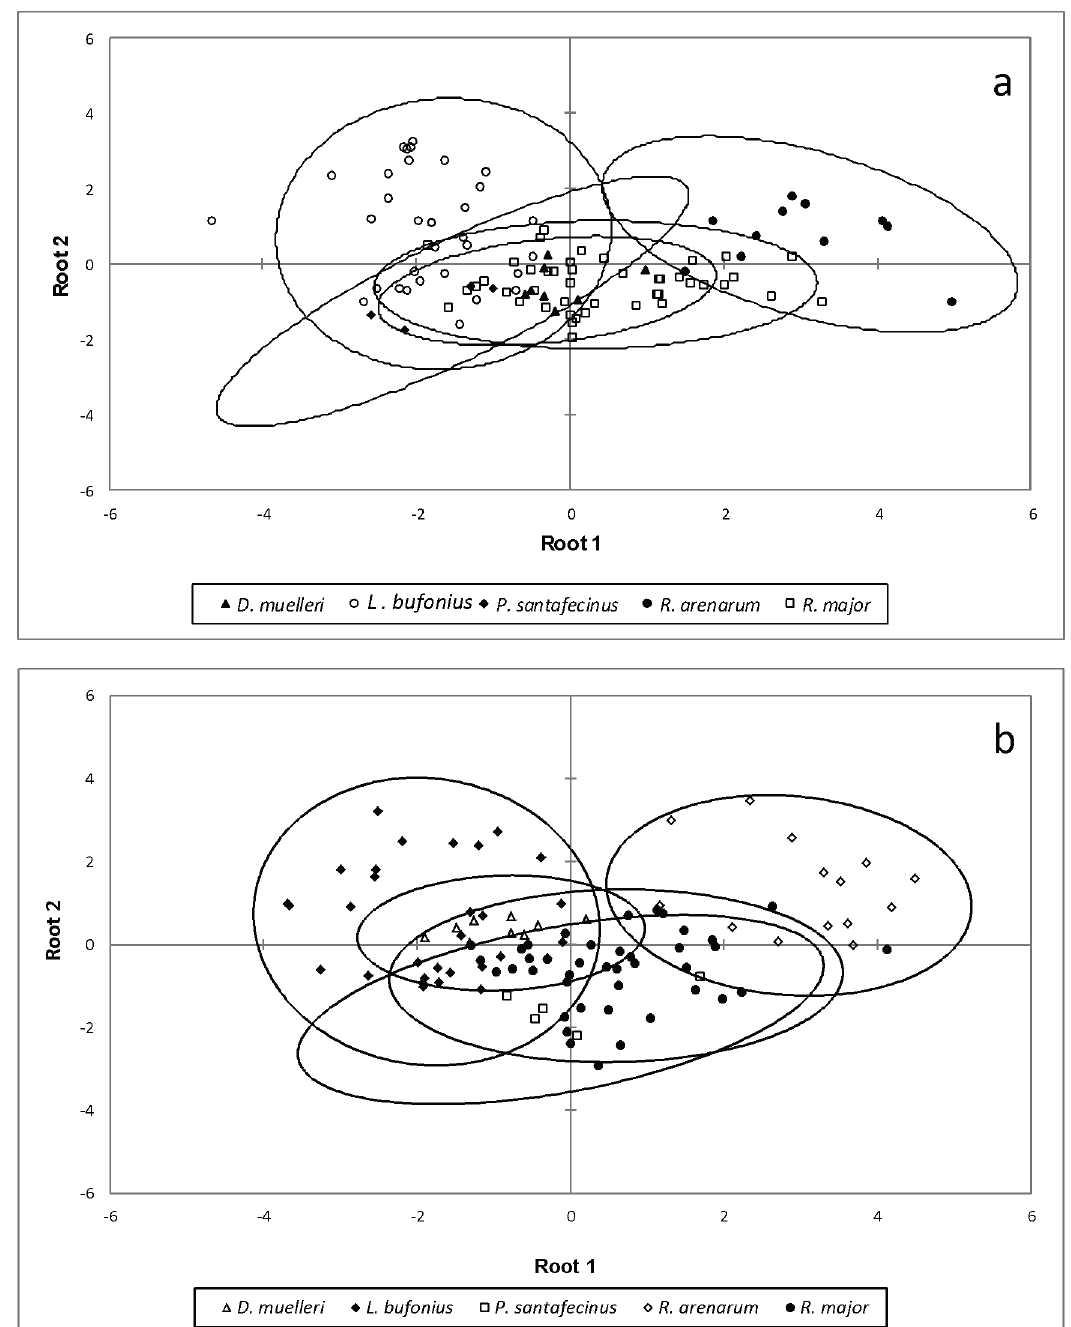
Figure 5 - (a) Plot of the 200 females specimens of the five host of Aplectana hylambatis against the first and second discriminant functions resulting from Linear Discriminant Analysis conducted with six variables (see text for explanation). The first two discriminant functions of the model accounted for 90.34% of the total variation among samples, cumulatively. Ellipses represent 95% confidence intervals. (b) Plot of the 201 males specimens of the five host of Aplectana hylambatis against the first and second discriminant functions resulting from Linear Discriminant Analysis conducted with five variables (see text for explanation). The first two discriminant functions of the model accounted for 93.28% of the total variation among samples, cumulatively. Ellipses represent 95% confidence